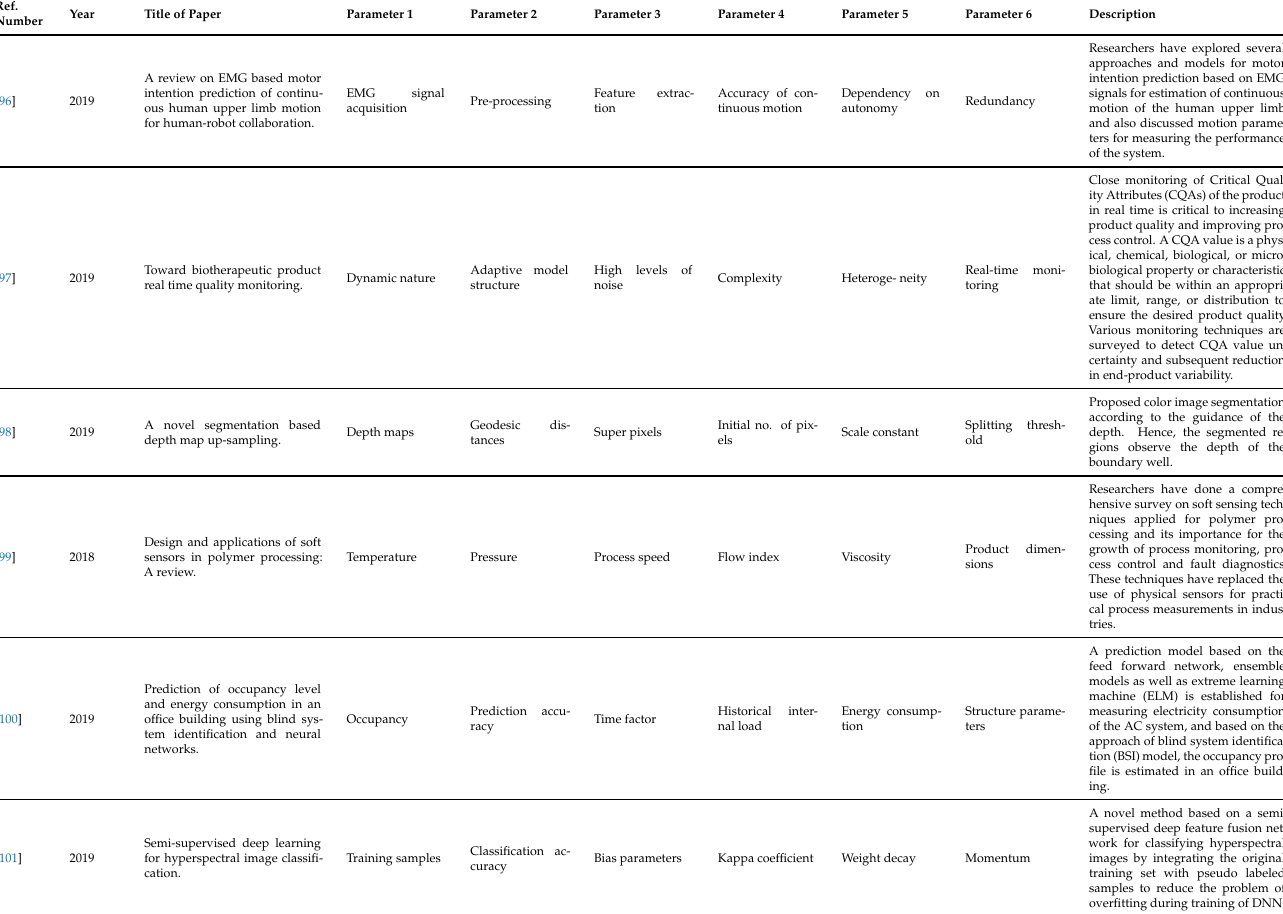
Table 4. Parameters Influencing the Performance of Intelligent